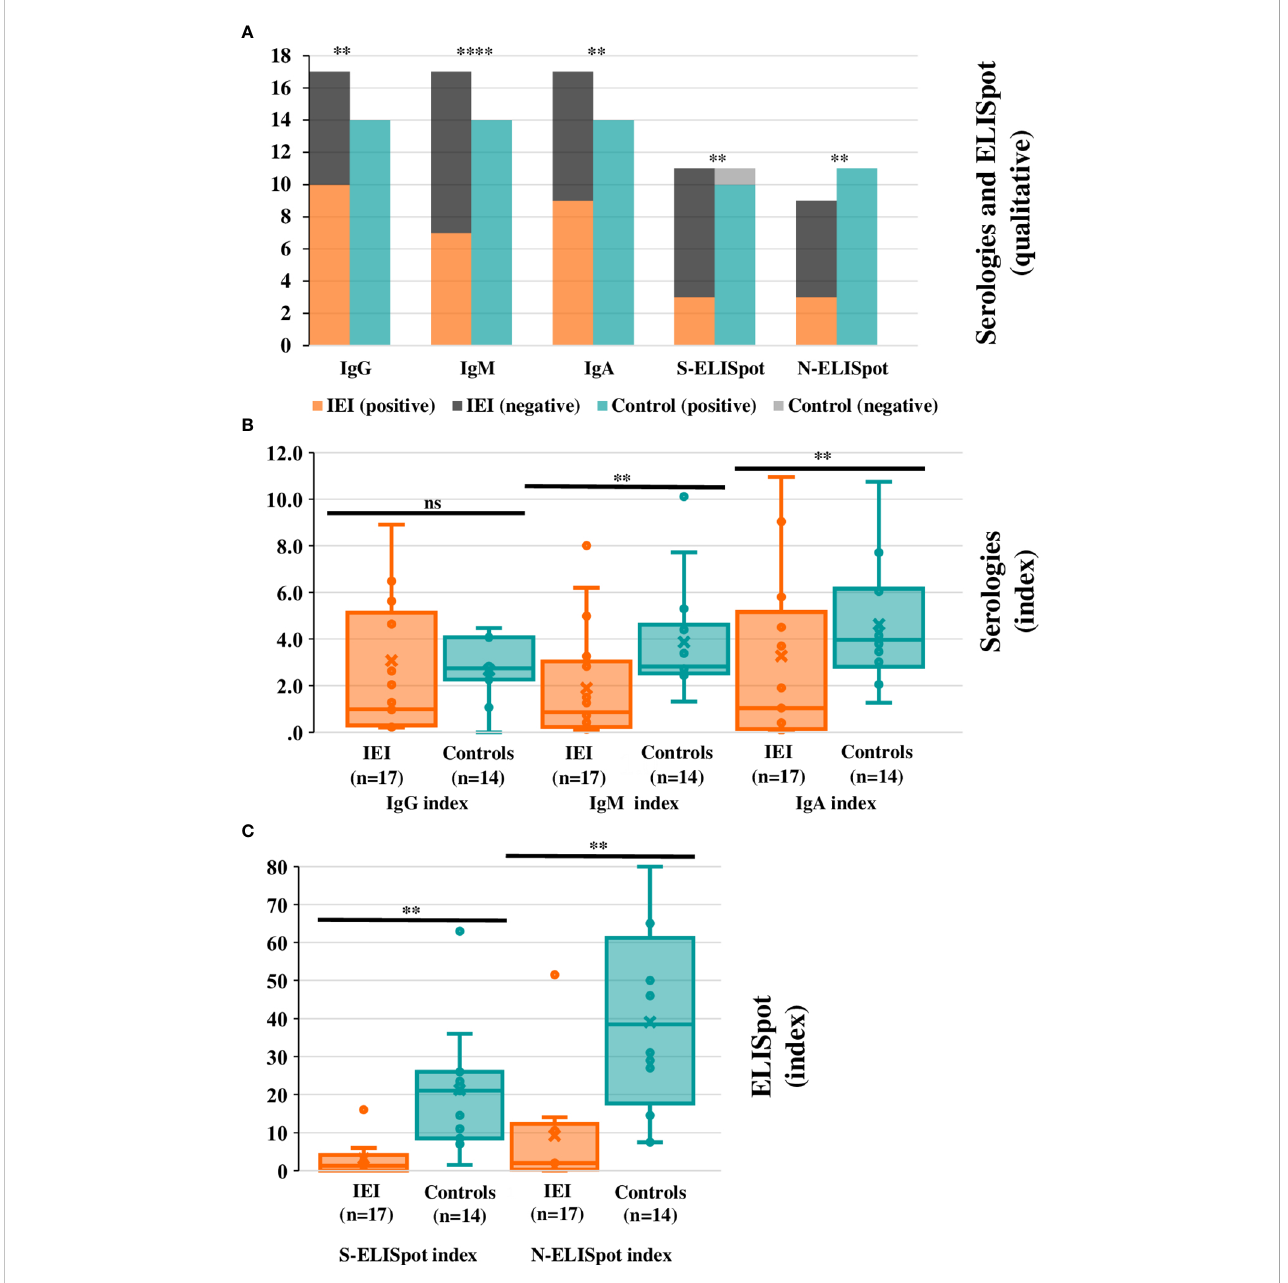
FIGURE 2 Humoral and cellular qualitative and quantitative responses in the acute phase post-SARS-CoV-2 infection. (A) Positive and negative SARS-CoV-2 speci fi c IgG + , IgM + , IgA + , S-, and N-ELISpot are represented in the bars for IEI patients and controls. Panel (B , C) Index averages for SARS-CoV-2 speci fi c IgG + , IgM + , IgA + (B) S-, and N-ELISpot (C) are represented in the box-plot diagrams for IEI patients and controls. The box horizontal middle line represents the median, the box extremes represent lower quartile (Q1) and higher quartile (Q3); maximum and minimum values (without outliers) are represented by the horizontal lines in the extremes of the whiskers. The individual values between quartile 1 and 3 are represented by dots; the mean is represented by an “ x ” symbol. There are two extreme values that are not represented in the box-plot graphic: IgG index for cases: 16.7 (P9); IgA index for cases: 16.1 (P24). For all panels signi fi cance levels are marked as *p ≤ 0.05, **:p ≤ 0.01, ***p ≤ 0.001, ****p ≤ 0.0001, ns: